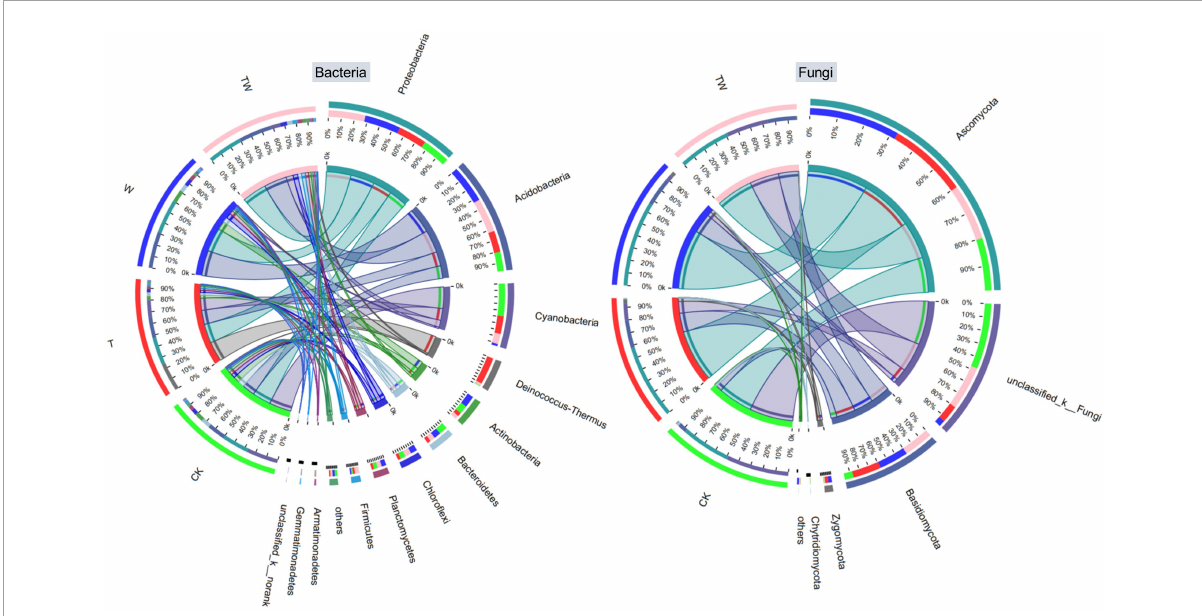
FIGURE5 Circos graph of bacterial (left) and fungal (right) community composition at the phyla level of the different treatments. CK, control; T, increasing temperature; W, increasing precipitation; TW, their interaction.